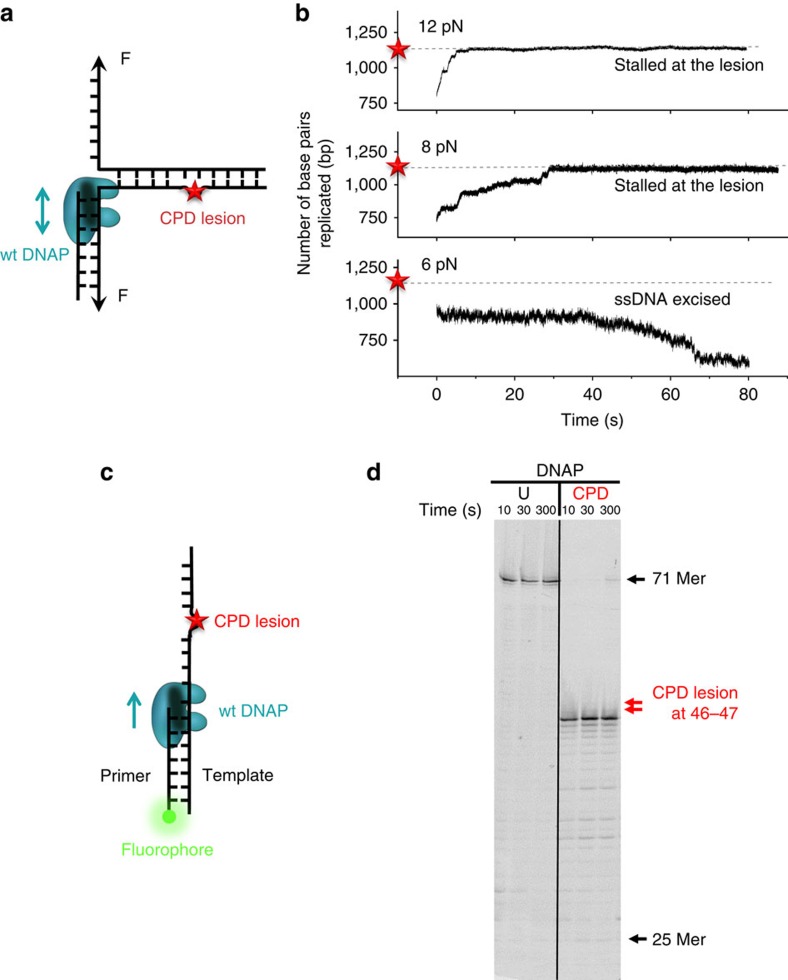
DNAP alone on a DNA template containing a CPD lesion.(a) Schematic representation of the single-molecule configuration. Two ssDNA arms were held at a constant force, while the motion of a T7 DNAP was monitored by the fork location. A single CPD lesion (red star) was located on the template strand. (b) Representative traces showing the number of replicated base pairs versus time in the presence of 1-mM dNTP (each) under 12, 8 and 6 pN. For clarity, traces have been shifted along the time axis. The dotted lines indicate the lesion position. Note that at 6 pN, DNAP excised DNA from the 3′ end. (c) Schematic representation of primer extension on a DNA template containing a single CPD lesion in ensemble studies. A 25-mer primer labelled with 5′ fluorescein was annealed to a 71-mer template containing a single CPD lesion at nucleotides 46 and 47. (d) A denaturing PAGE analysis of primer extension by DNAP on either an unmodified template (no CPD lesion, denoted as ‘U') or a CPD-containing DNA template (denoted as ‘CPD').